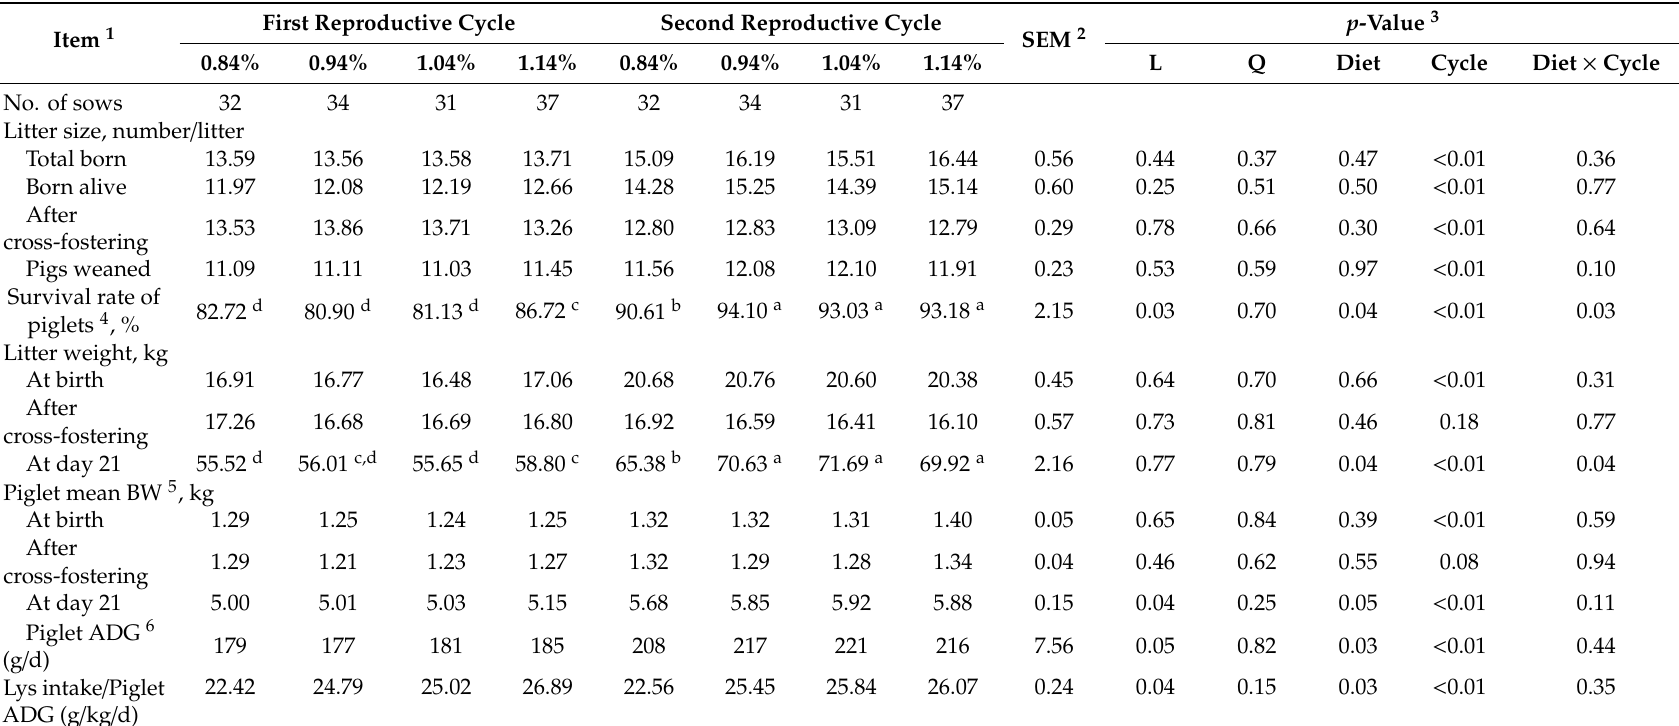
Table 3. E ff ects of di ff erent levels of lysine in lactation diets on the growth performance of